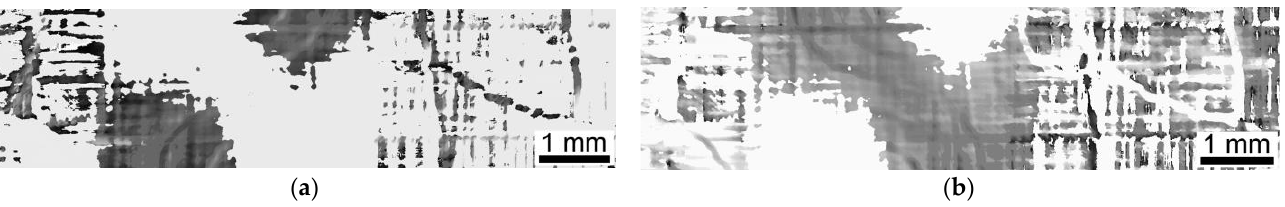
Figure 17. Spatial distribution of shear angles, varying within 91 ◦ − 179 ◦ ( a ) and 0 ◦ − 90 ◦ ( b ). All pseudo-images on ( a , b ) were obtained under the following conditions: ε = 0.037, ∆ ε = 0.012, T = . .